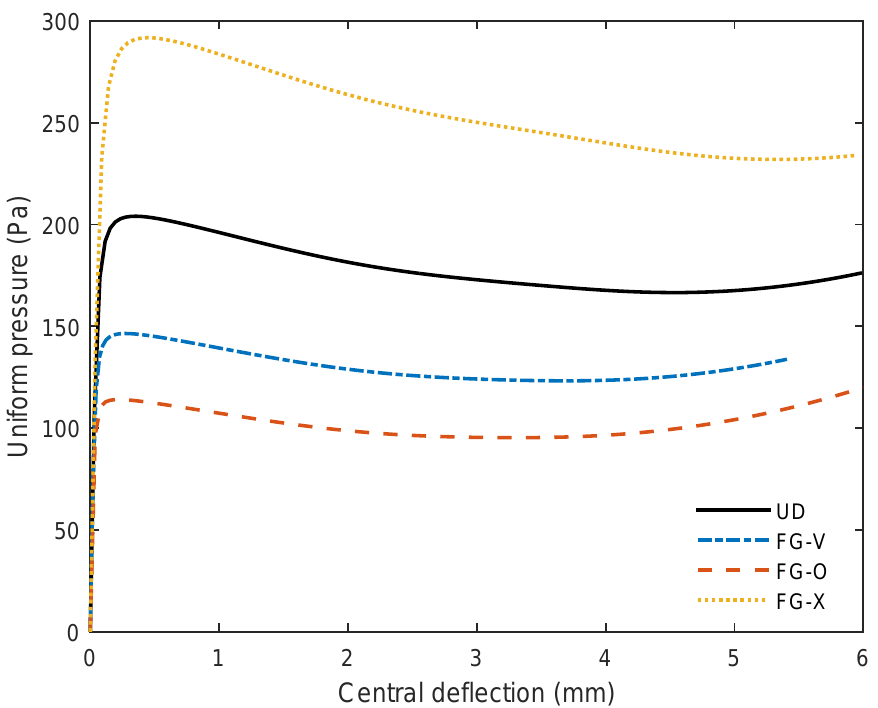
Figure 7. Effect of CNTs distribution on nonlinear response of the fully clamped FG-CNTRC cylindri- = 0.11, h = 0.5 mm, κ = 0.2. cal membrane with V ∗ CNT